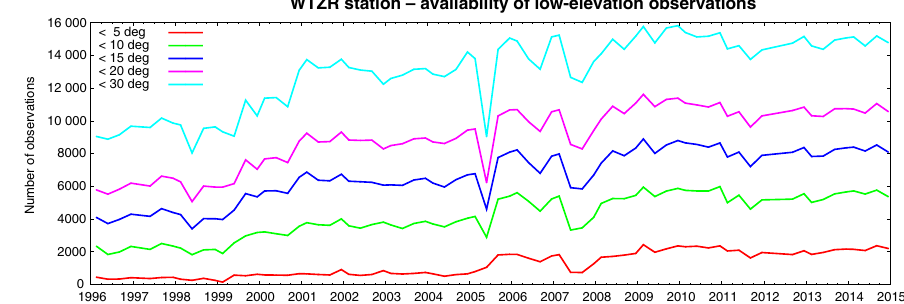
Figure 15. Availability of observations at low-elevation angles (below 5, 10, 15, 20 and 30 ◦ ) for the WTZR